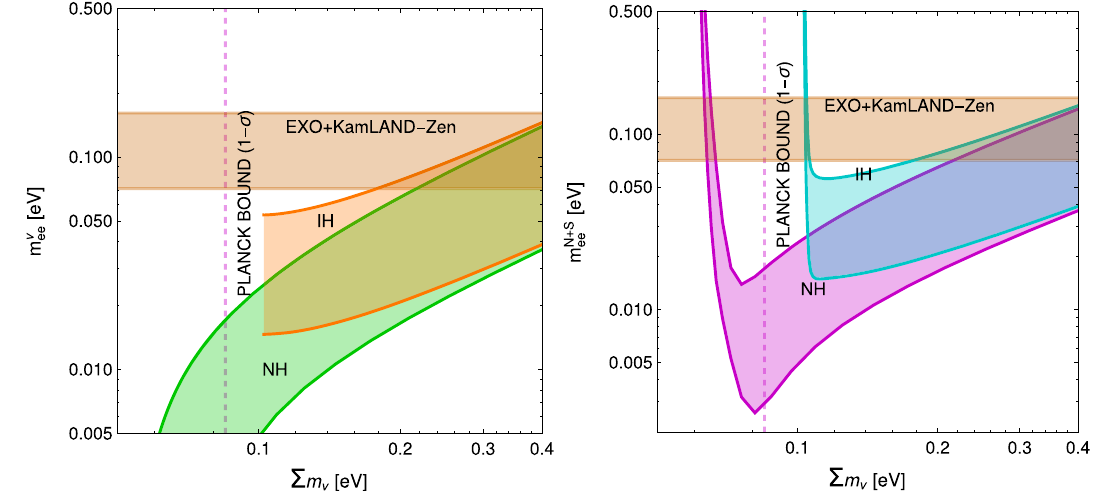
Fig. 11 Allowed region of effective Majorana mass parameter ( | m ee | ) as a function of sum of light neutrino masses ( (cid:18) m i ) for standard mechanism (left-panel) and new physics contributions from N R and S L mediated diagrams (right-panel)